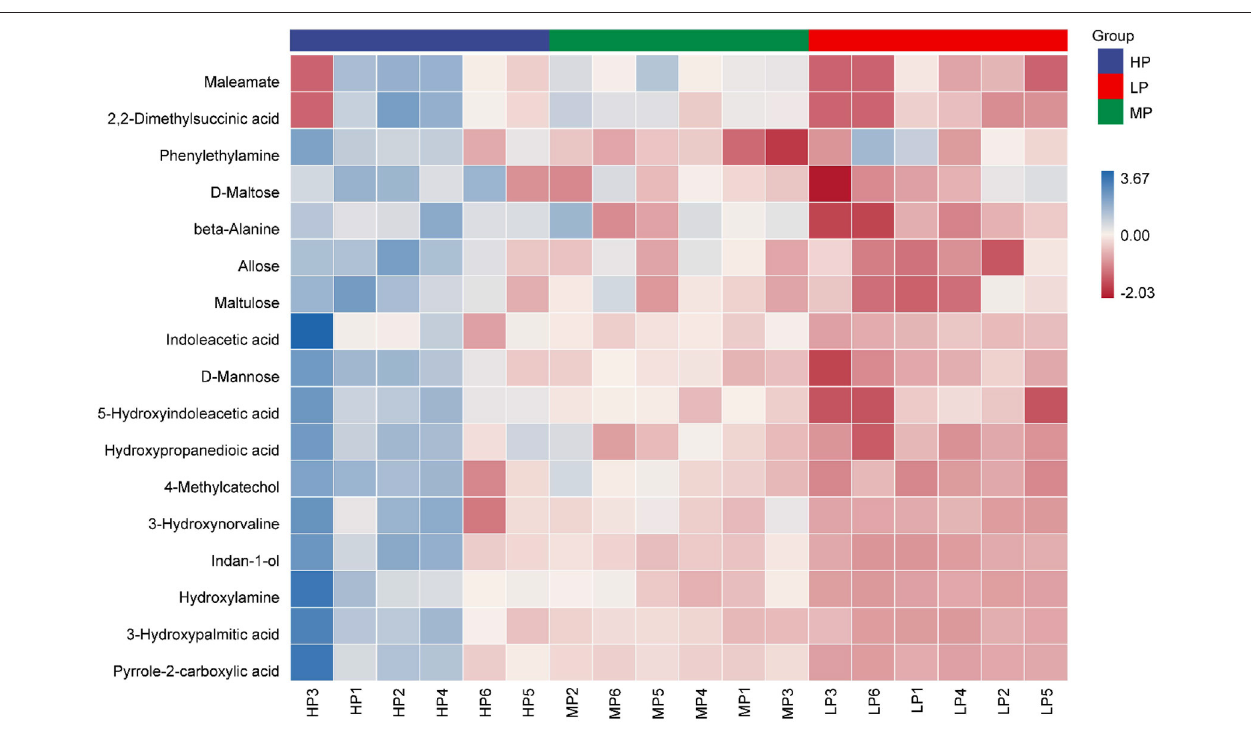
FIGURE 4 | Heatmap of differential metabolites in rumen fluid samples between different groups.